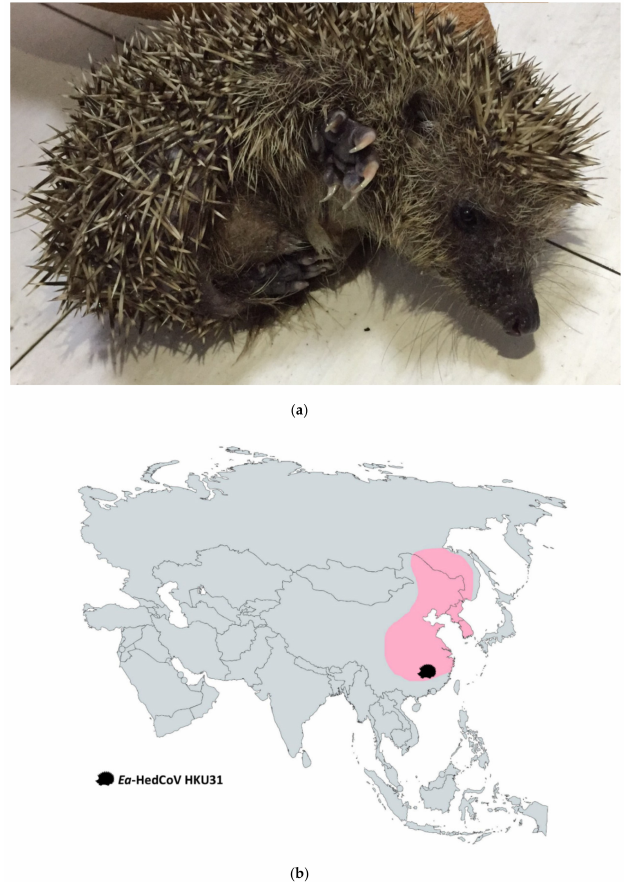
Figure 1. ( a ) Erinaceus amurensis , also known as Amur hedgehog or Manchurian hedgehog, sampled in this study; ( b ) Geographical distribution of Erinaceus amurensis in Asia. The colored region represents the habitat where Erinaceus amurensis resides. The labeled area represents the location where Ea-HedCoV HKU31 was